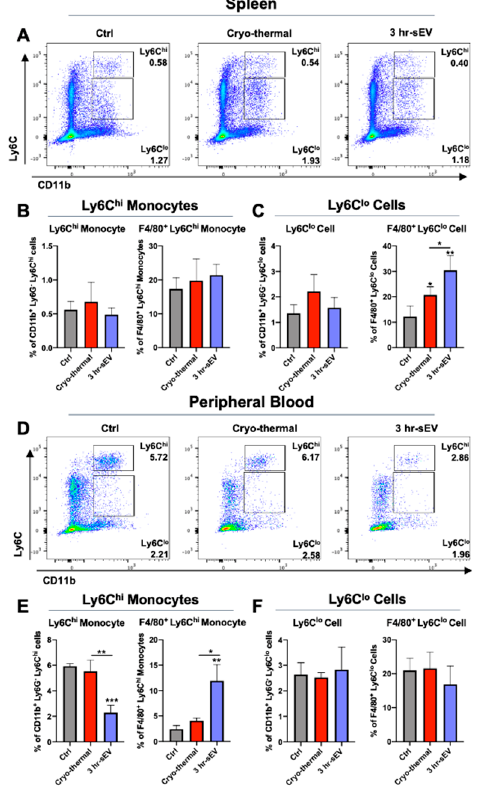
Figure 4. Supplement of sEVs after cryo-thermal therapy promoted the differentiation of monocytes to macrophages. ( A , D ) Flow cytometry gating strategy for determination of CD11b + Ly6C hi mono- cytes and CD11b + Ly6C lo monocytes in Ly6G - cells in spleen ( A ) and peripheral blood ( D ). ( B , C ) Pro- portions of Ly6C hi monocytes ( B ), Ly6C lo monocytes ( C ) and their expression of F4/80 in spleen. ( E , F ) Proportions of Ly6C hi monocytes ( E ), Ly6C lo monocytes ( F ) and their expression of F4/80 in pe- ripheral blood were detected by flow cytometry. n = 4 per group. Data were shown as mean ± SD, and the Student’s t-test was used for statistical analysis. * p < 0.05, ** p < 0.01, *** p < 0.001.